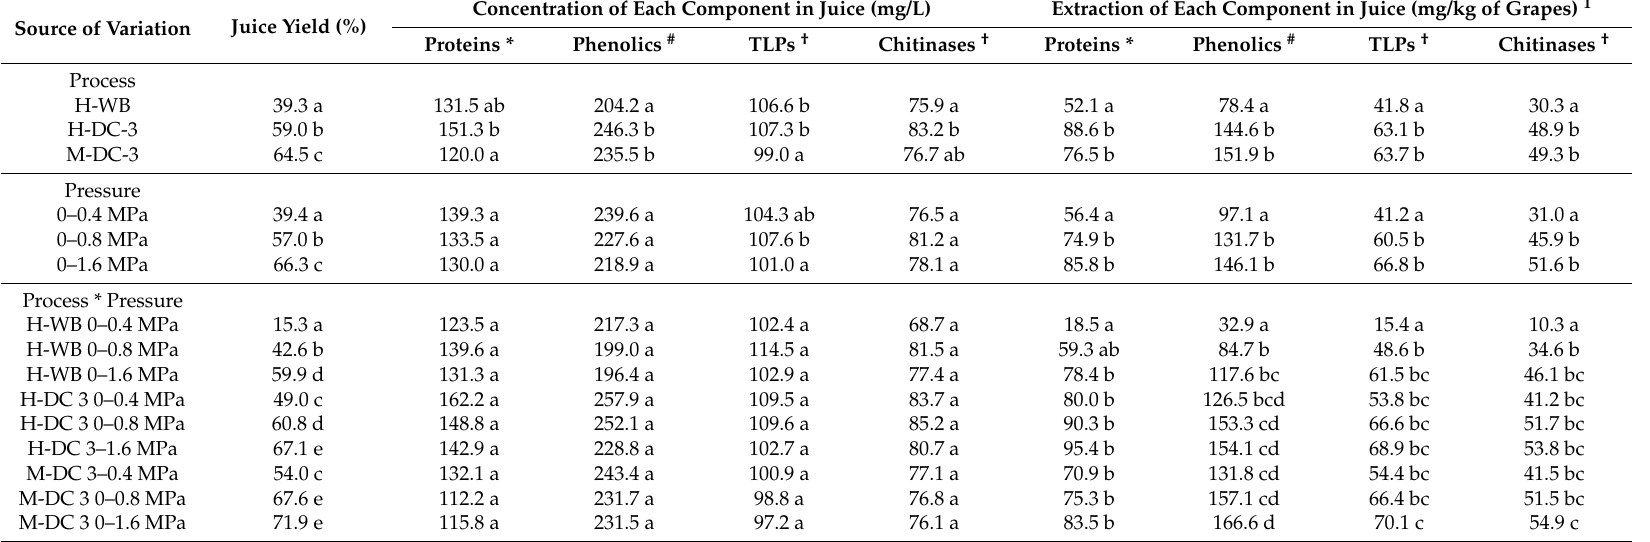
Table 3. Statistical analysis of juices from three